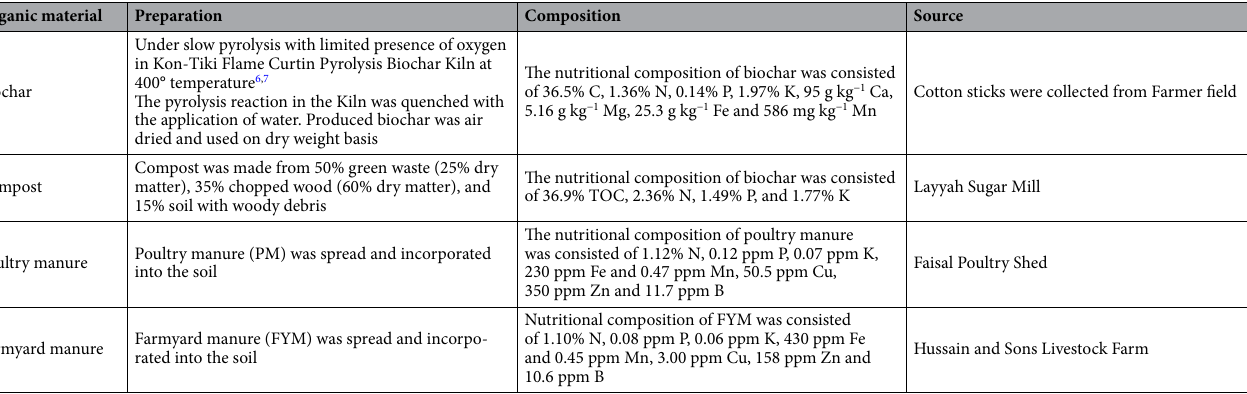
Table 5. Preparation method, nutritional composition, and source of biochar, compost, poultry and farmyard